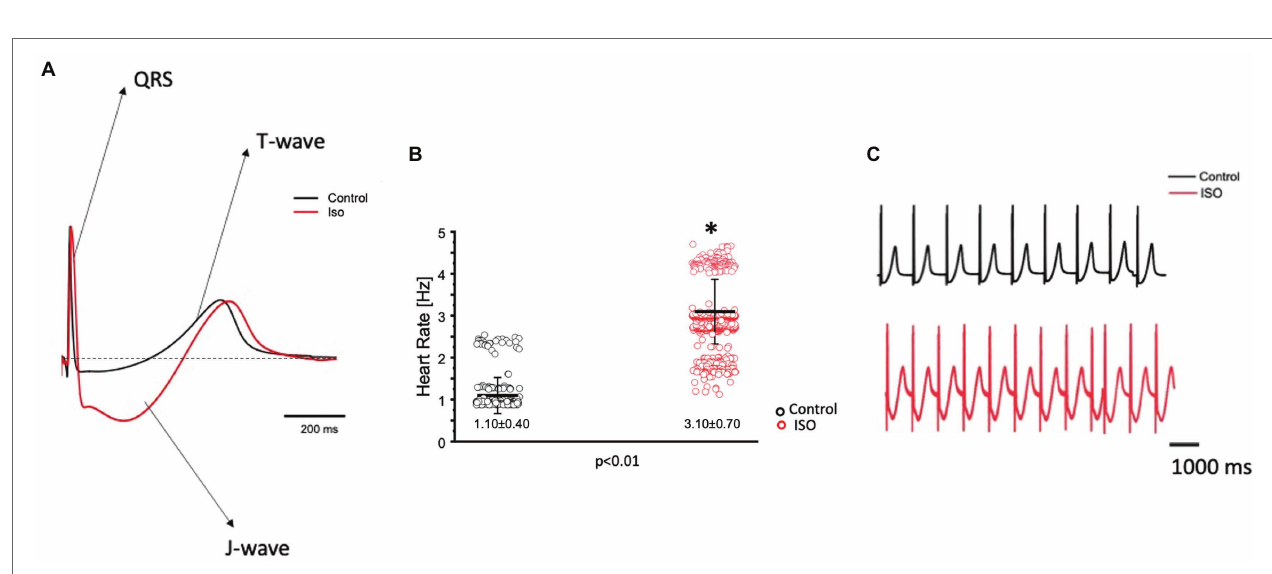
FIGURE 2 | Kinetic parameters of the Goldfish ventricular action potential before (black) and after (red) perfusion with 100 nm isoproterenol. Following isoproterenol perfusion, APD30s significantly increased from 228.10 ± 14.40 ms to 237.90 ± 11.80 ms ( p < 0.01, n = 113 for the control, n = 113 for ISO, N = 4; A ), APD50 decreased from 353.90 ± 30.40 ms to 300.30 ± 20.00 ms ( p < 0.01, n = 143 for the control, n = 316 for ISO, N = 4; B ), and APD90 significantly increased from 455.40 ± 20.10 ms to 468.70 ± 27.00 ms ( p < 0.01, n = 95 for the control, n = 256 for ISO, N = 4; C ). * Denotes a significant difference between the two distributions. The data are presented as multiple measurements (n; dot cloud) recorded for different measurements ( n ) on different hearts ( N ) with the mean ± SEM (solid lines).